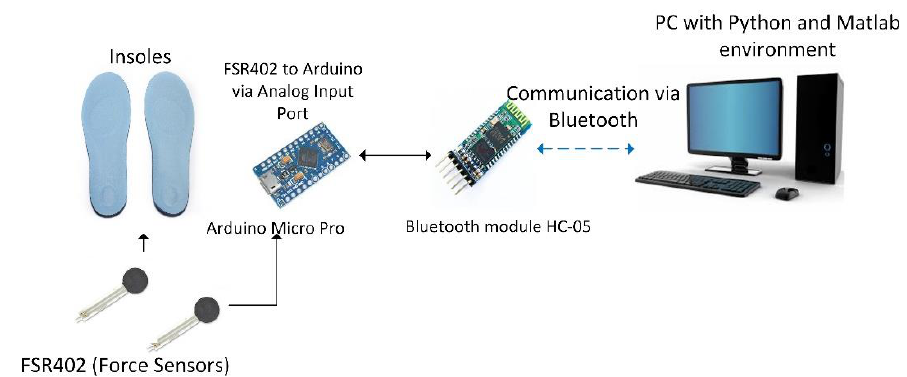
Figure 2. The hardware system diagram of the FSR-based insoles for measuring the flatfoot and normal foot.